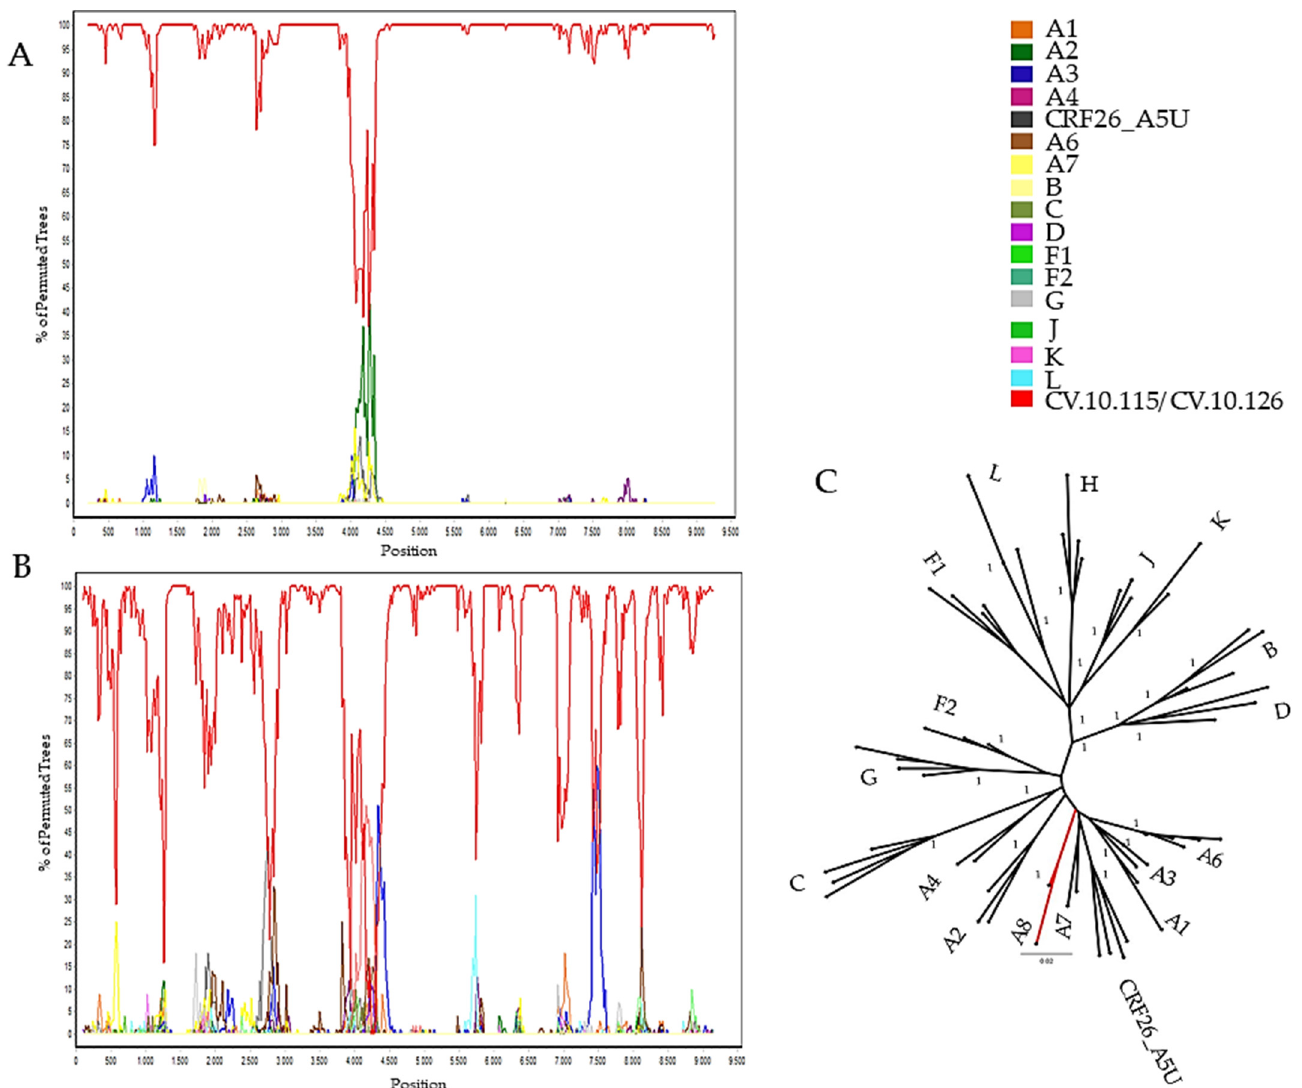
Figure 2. Investigation of genome recombination. Bootscan analysis was performed using a sliding window of 400 nt by increments of 20 nt. ( A ) CV.10.115, ( B ) CV.10.126, and ( C ) Maximum likelihood (ML) tree was implemented for fragments measured when bootscan analysis was above 70% of permuted trees. ML implementing nucleotide substitution model GTR was generated from the alignment position 4000 to 4500, supporting the classification of sub-subtype A8 (in red). ALRT values were represented only if >0.90. Reference sequences GenBank accession number as follows: Ref.B-K03455,AY423387, AY173951, AY331295; Ref.C-U52953,U46016,AF067155,AY772699; Ref.D-K03454, AY253311, U88824; Ref.F1-AF077336, AF005494,AF075703AJ249238;